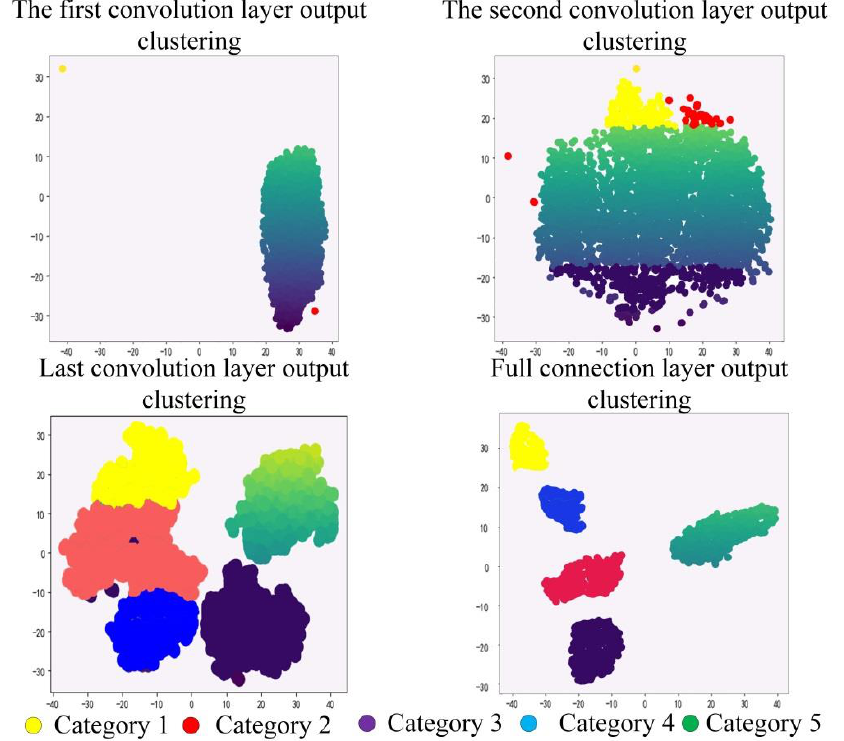
Figure 10. TSNE clustering